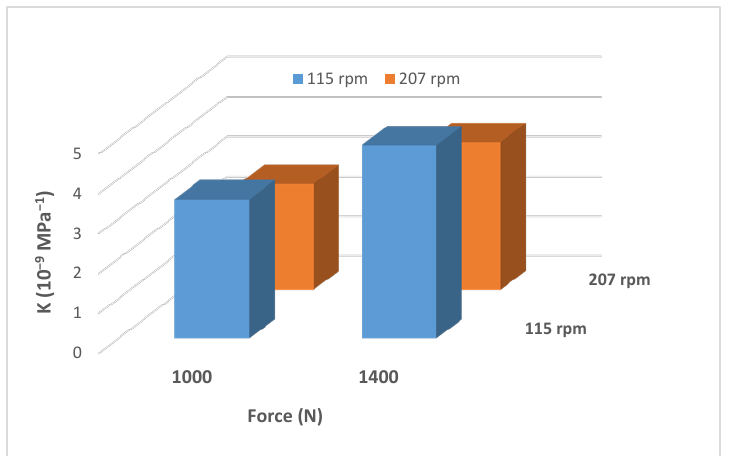
Figure 6. Wear factors of P110 tested under oil-based wet conditions, at two different loads and two different speeds.